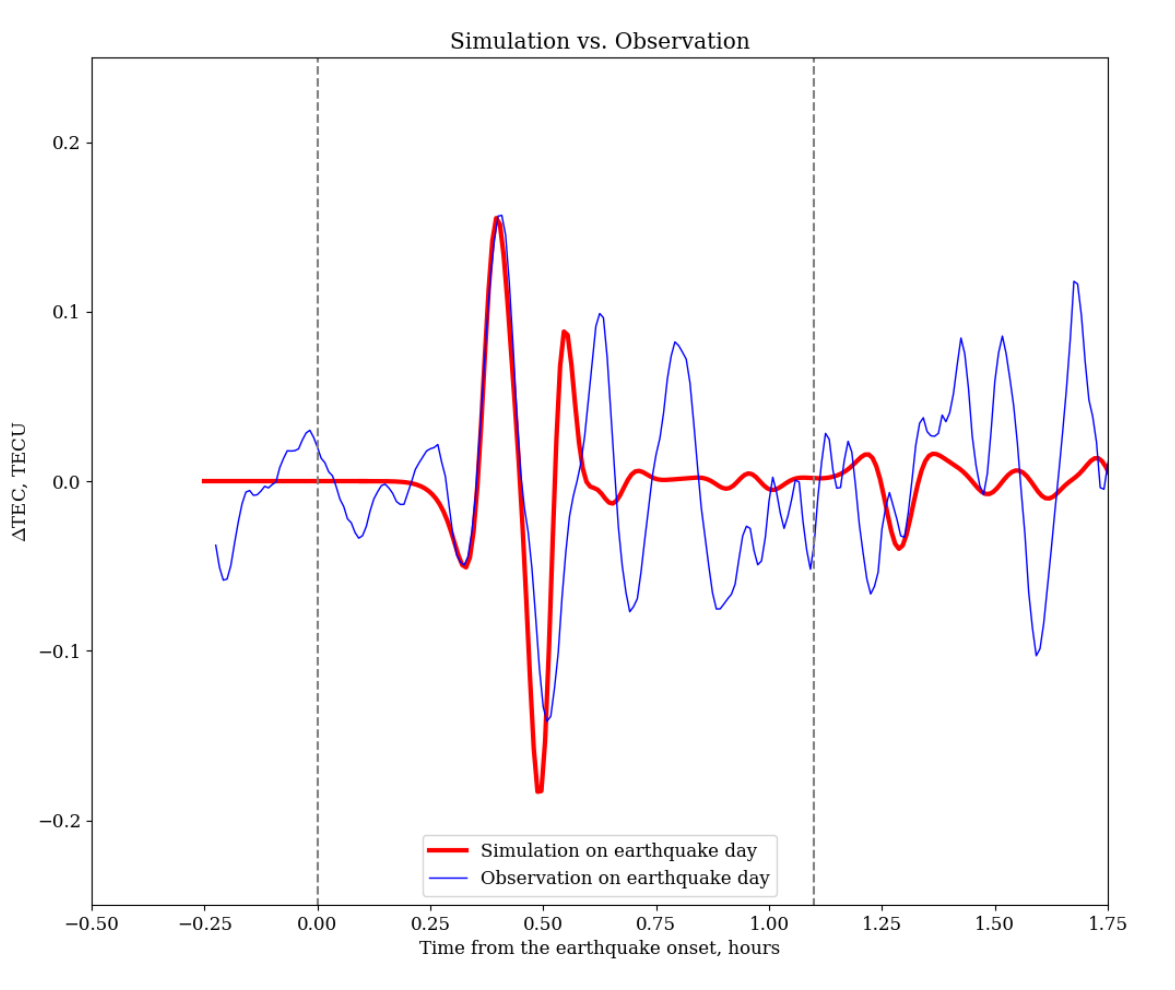
Figure 9. Comparison of simulation and observation results for the IPP trajectory, as registered from the BGIS station: simulated and observed ∆ TEC of the earthquake